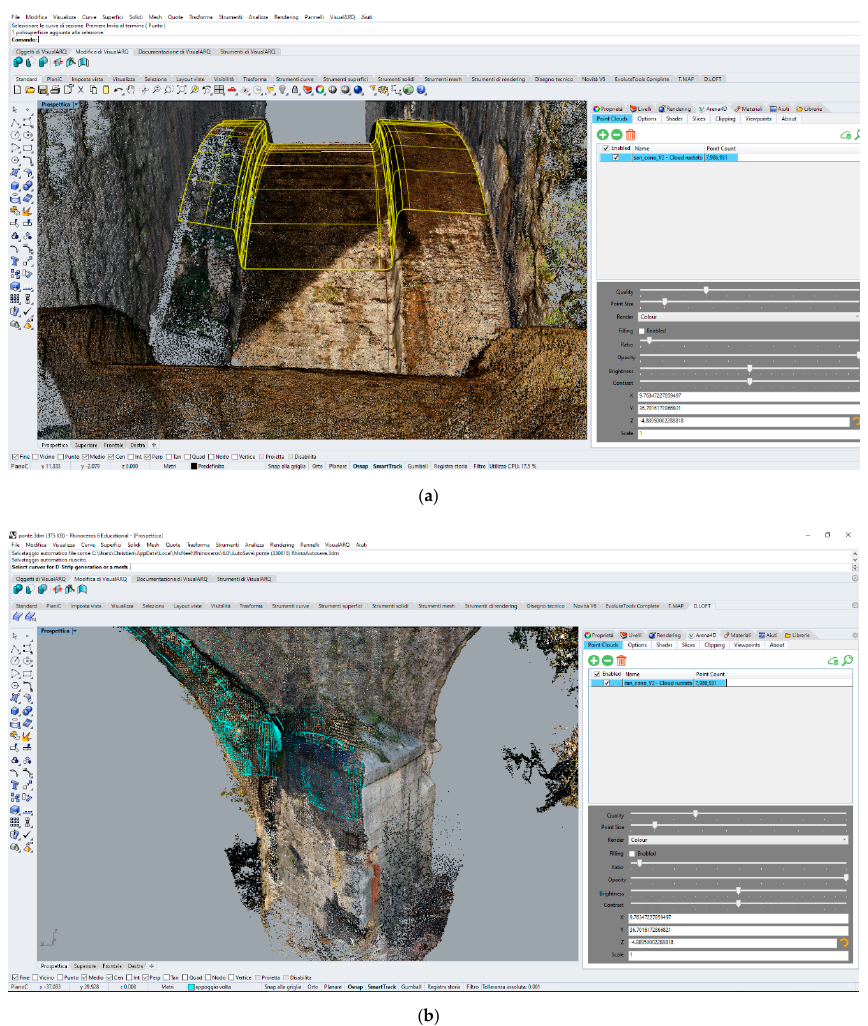
Figure 11. Adaptation of the non-uniform rational B-spline (NURBS) to the existing surface of the masonry bridge: detail of the arches ( a ) and of a pylon ( b ).